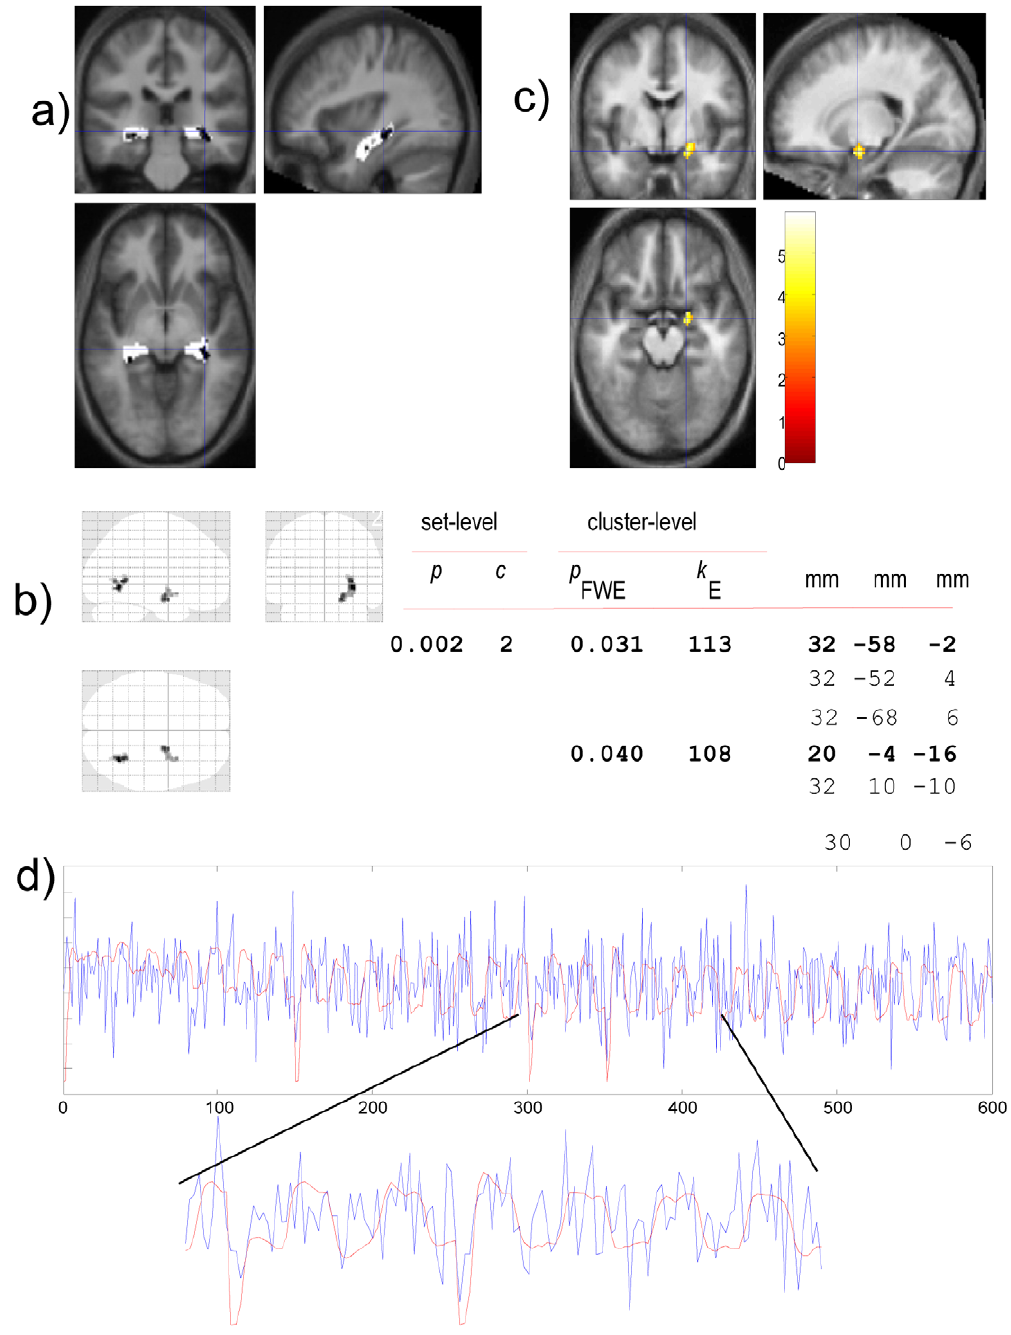
Figure 4. Structural MRI, mask and functional activation. ( a ) Structural region-of-interest (white) on the subjects’ average anatomical image. For visualization, black blobs exceed the 0.05 level uncorrected threshold corresponding to a Student’s t (13 df). See the main text for statistical inference at a corrected p , 0.05 level. ( b,c ) Whole brain analysis of the effect of ambiguity. ( b ) Shows a glass-brain view (maximum intensity projection) of significant activations. ( c ) Shows the anterior activation, which included right anterior hippocampus and amygdala as defined, superimposed on the subjects’ average anatomical image. ( d ) The observed fMRI trial-by-trial time-series (blue) averaged over all subjects for the hippocampal activation identified in our whole brain analysis (see main text). The model-based ambiguity is shown in red. Note that the model only captures the slow changes in observed responses over blocks as the contingencies are learned.